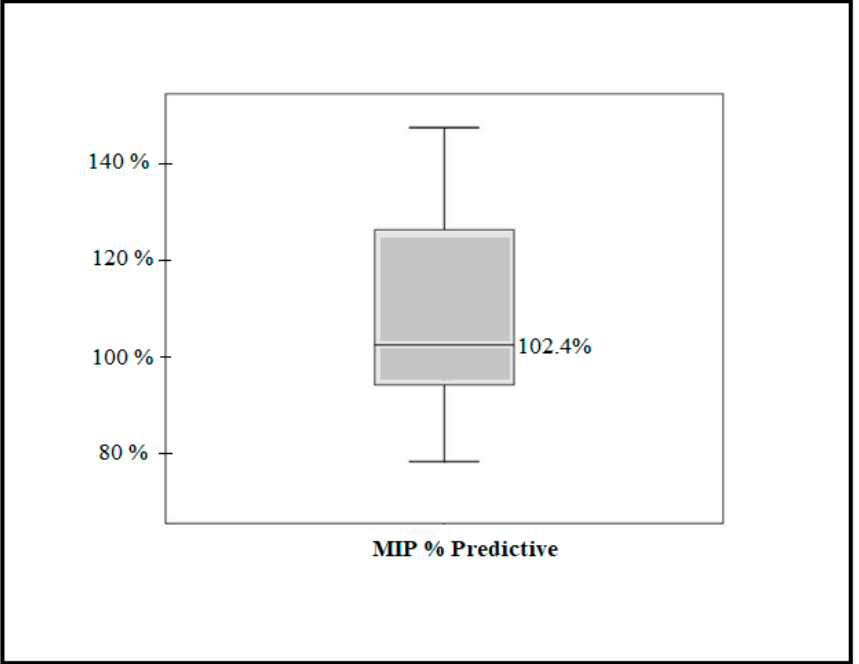
Figure 2. Baseline inspiratory muscle strength (MIP% predictive).